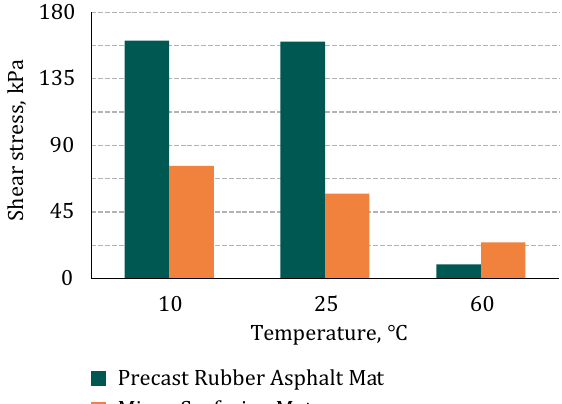
a) interfacial shear strength